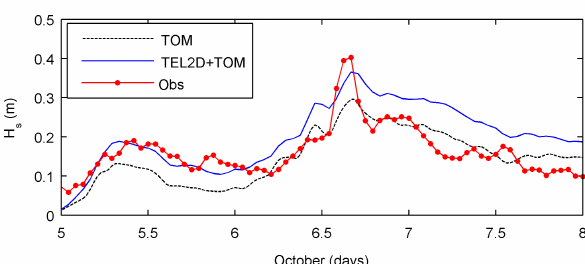
Figure 7. Significant wave height, H s , at the Mar Grande station in the period 5–7 October 2014: numerical results from the standalone TOM run (black dotted line), the coupled TEL2-D + TOM run (blue line) and observations (red line and circle markers).